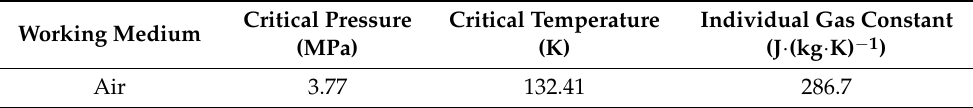
Table 1. Physical parameters of the air.